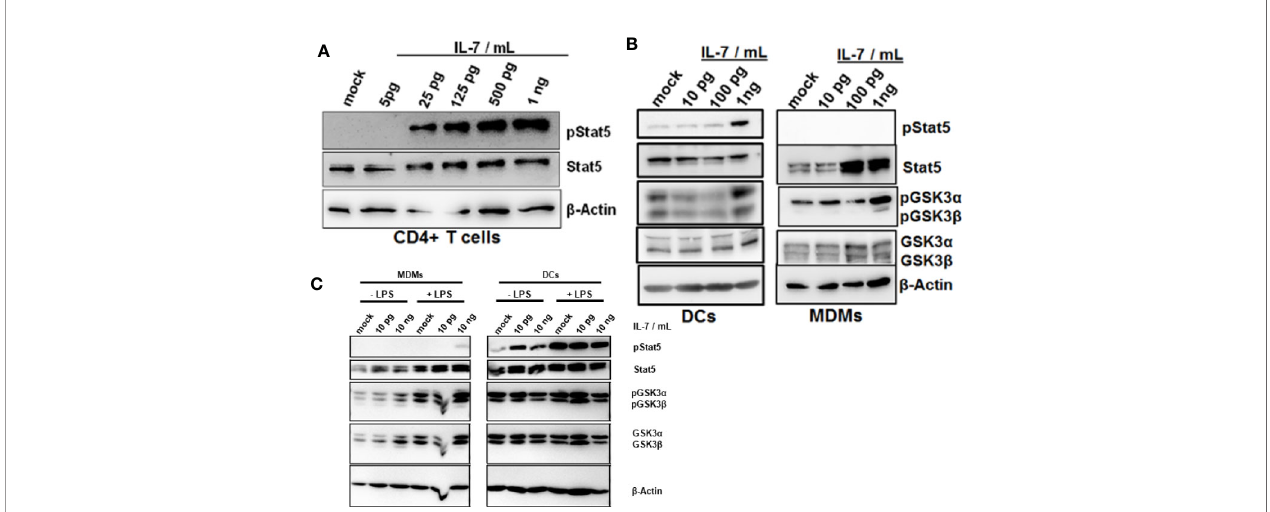
FIGURE 5 | Phosphorylation of Glycogen synthase kinase-3 (GSK3) in dendritic cells (DCs) and macrophages in response to interleukin-7 (IL-7). (A) Naive CD4 T cells were treated with ascending concentrations of human IL-7 for 15 min. Presence of phosphorylated and total Stat5 was analyzed by Western Blot. (B) Human monocytes were differentiated into monocyte-derived DCs (left panel) or monocyte-derived macrophages (MDMs) (right panel). Cells were pre-incubated with 10 ng/ ml lipopolysaccharide (LPS) for 48 h before treatment with the displayed concentrations of IL-7 for 15 min. Presence and phosphorylation status of proteins (i.e. Serine 21/9 phosphorylation on GSK3 a and GSK3 b respectively and Tyrosine 694 phosphorylation on Stat5) was assessed using Western Blot with b -Actin as control. (C) monocyte-derived macrophages (MDMs) and DCs were stimulated with or without 10 ng/ml LPS for 16 h before incubation with the different concentrations of IL-7 (10 pg/ml or 10 ng/ml) for 15 min. Presence and phosphorylation status of proteins (i.e. Serine 21/9 phosphorylation on GSK3 a and GSK3 b respectively and Tyrosine 694 phosphorylation on Stat5) was assessed using Western Blot with b -Actin as control. In (A – C) , one out of three experiments (n=3) is shown as